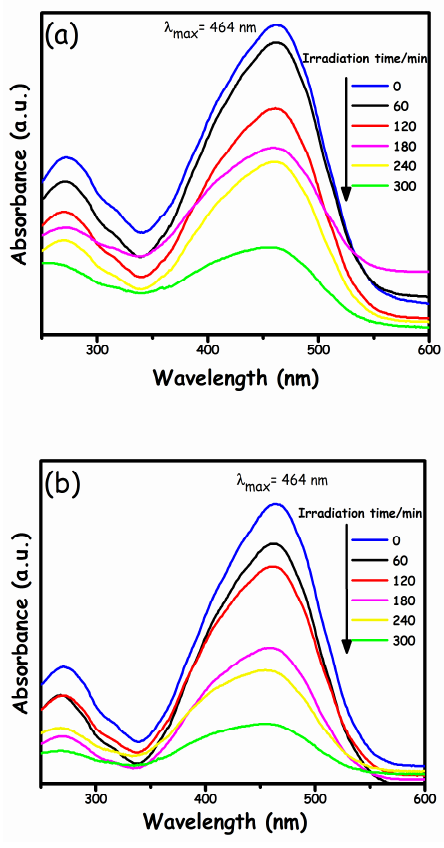
Figure 6. UV-vis absorption spectral changes of MO with time in ( a ) pure g-C 3 N 4 and ( b ) g-C 3 N 4 /α Fe 2 O 3 nanocomposite under light illumination.